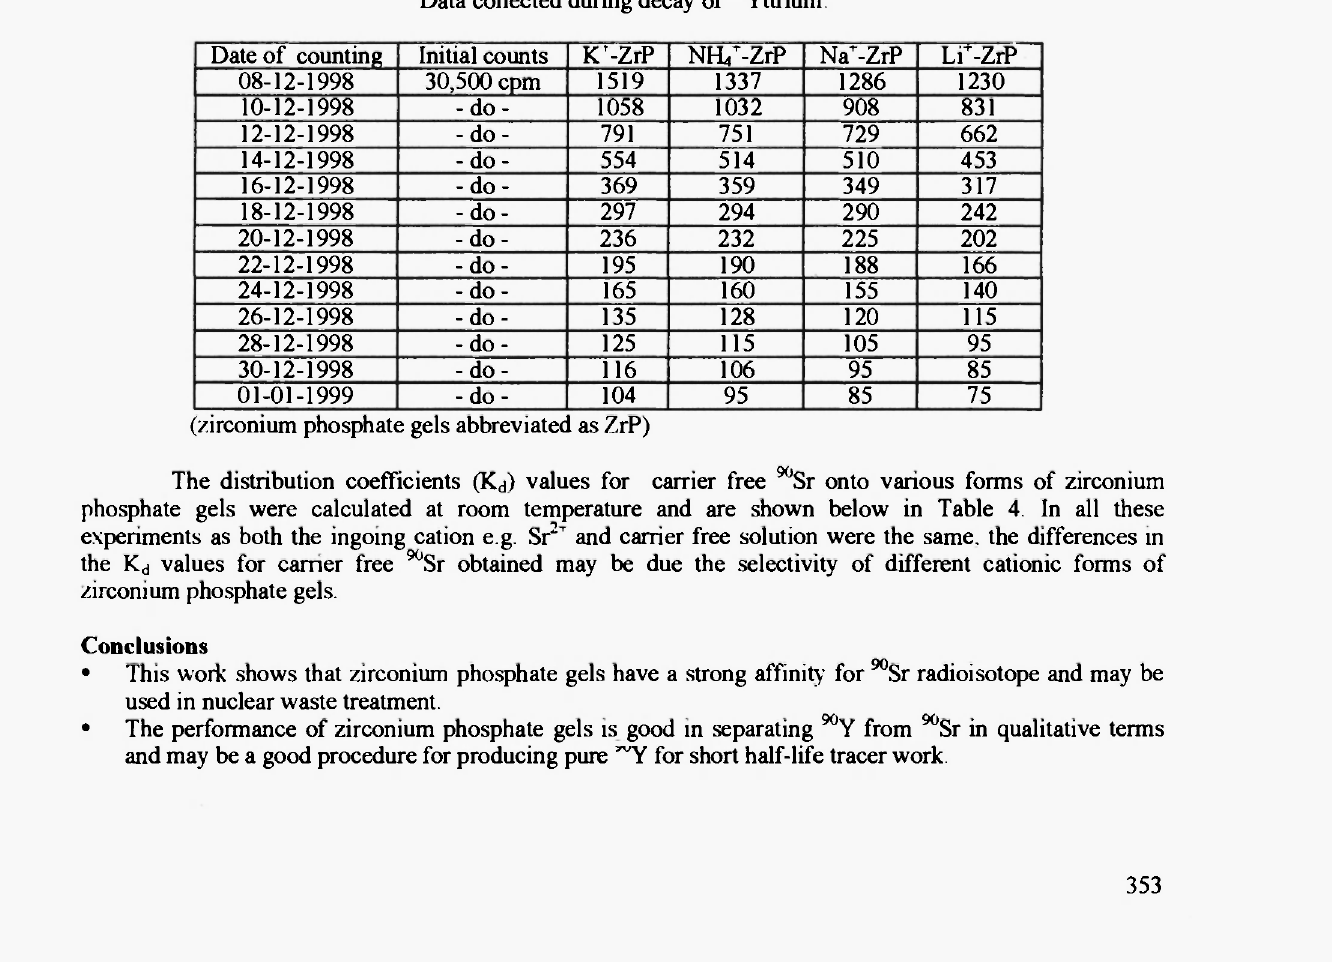
Data collected during decay of